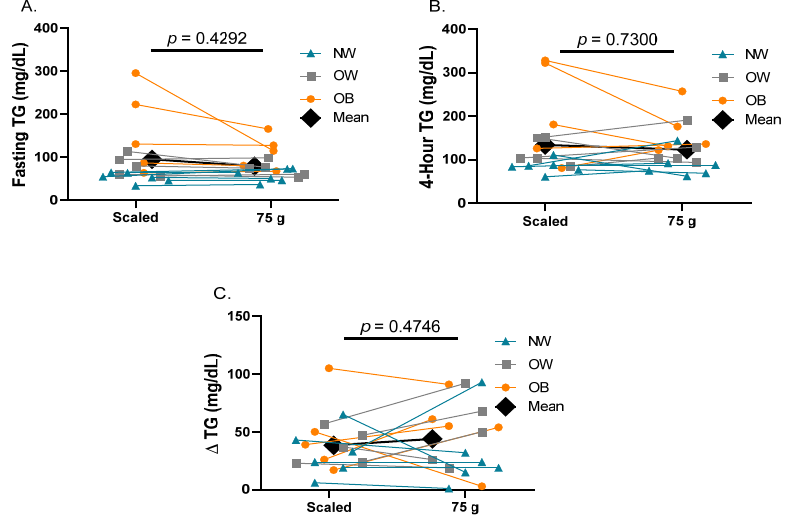
Figure 1. Postprandial Triglyceride Responses to a Scaled to Body Weight versus 75 g High-fat Meal . ( A ) Fasting triglycerides, ( B ) 4 h triglycerides, and ( C ) Change in triglycerides in the scaled- to-body-weight and 75 g fat tolerance tests. Each pair of connected data points represents the same individual at each study visit. Data are presented as mean ± SD. Abbreviations: NW normal weight; OW overweight; OB obese; TG triglycerides. Table 2. Postprandial Triglyceride Responses to the Scaled and 75 g High-fat Meals within BMI Category .